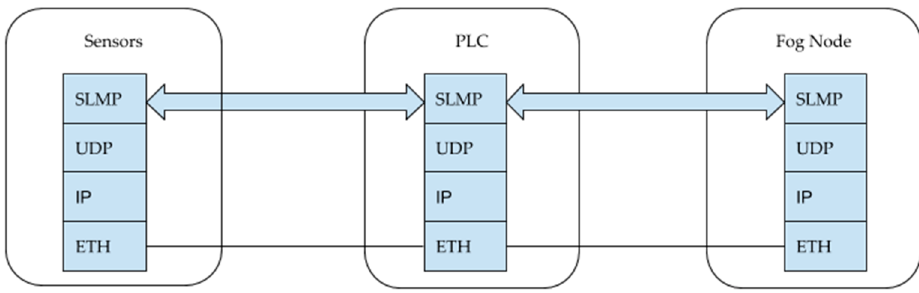
Figure 11. Communication between sensors, Industrial Programmable Logic Controllers (PLCs), and Odroid in a Fog-oriented DC model.